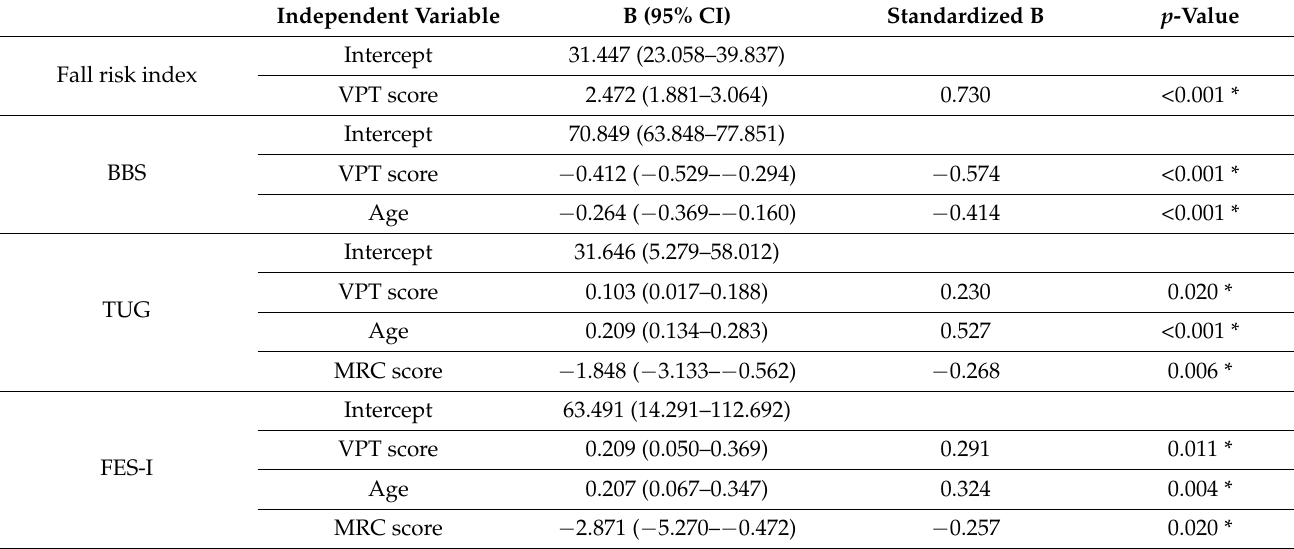
Table 6. Factors associated with postural steadiness, functional balance, and fear of falling in patients with type 2 DM. Independent Variable B (95%